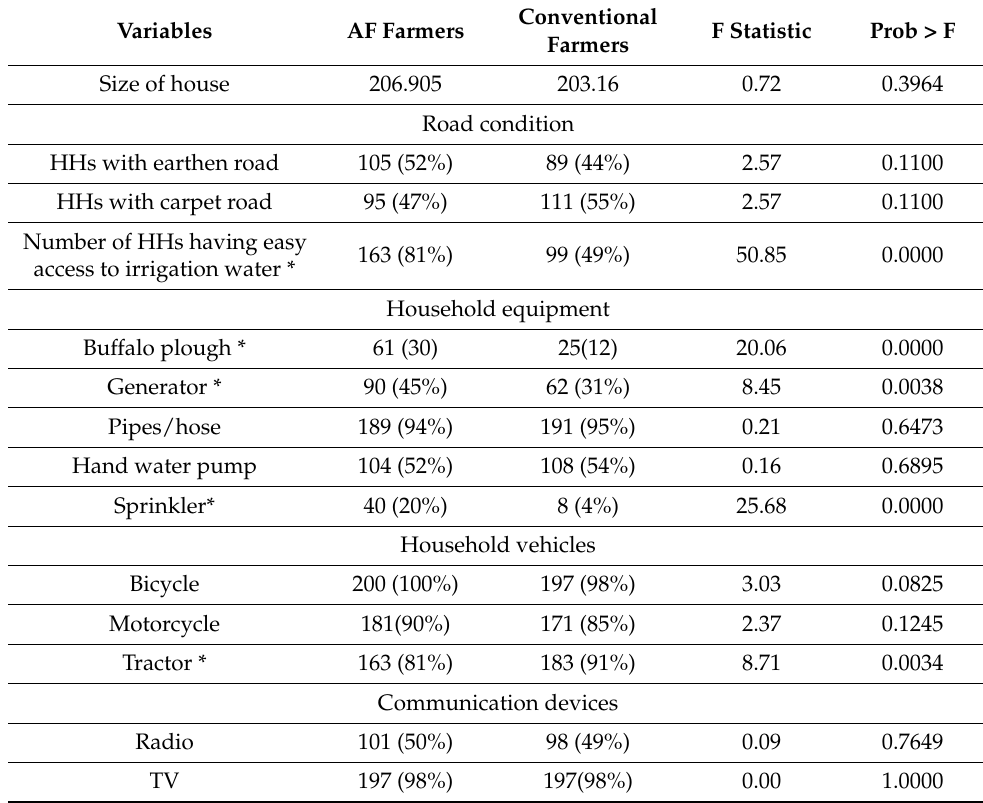
Table 3. Comparative analysis of the physical capital of AF and CF